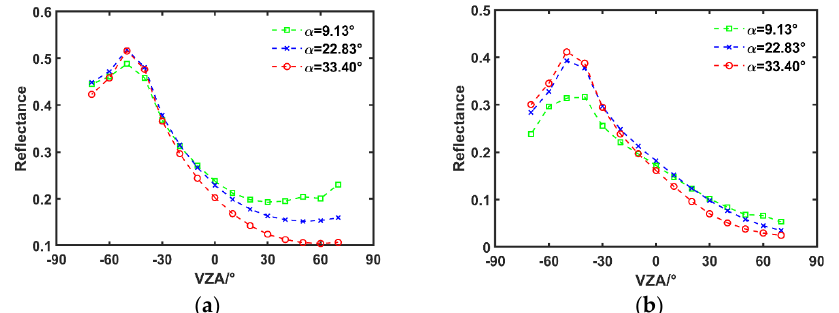
Figure 2. BRFs of three rugged terrains in LESS simulations along the principal plane, (SZA = 45°, SAA = 0°; ( a ) NIR Band and ( b ) Red Band) The negative and positive values on the abscissa represent the back- and forward-scattering directions in the PP, respectively. The SZA, SAA, VZA, and VAA of each rugged terrain scene are the same; only the average slope is different.